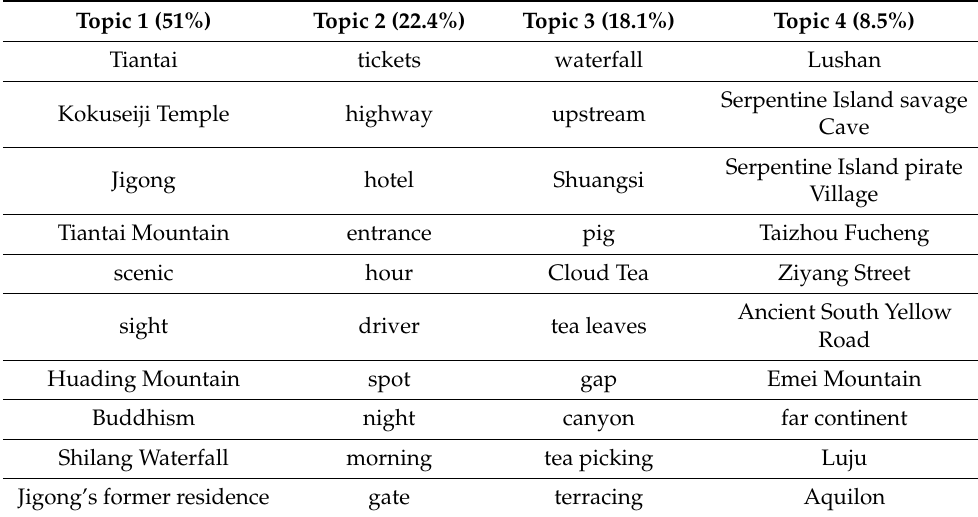
Table 2. LDA classification themes and feature words (top